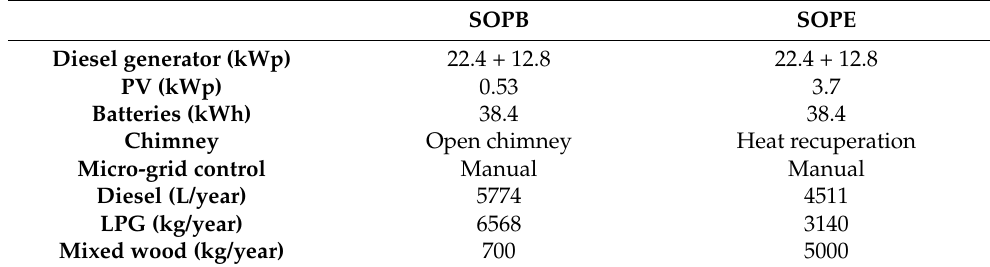
Table 1. State of play of the Lizara hut at the beginning (SOPB) and after modifications (SOPE). SOPB SOPE